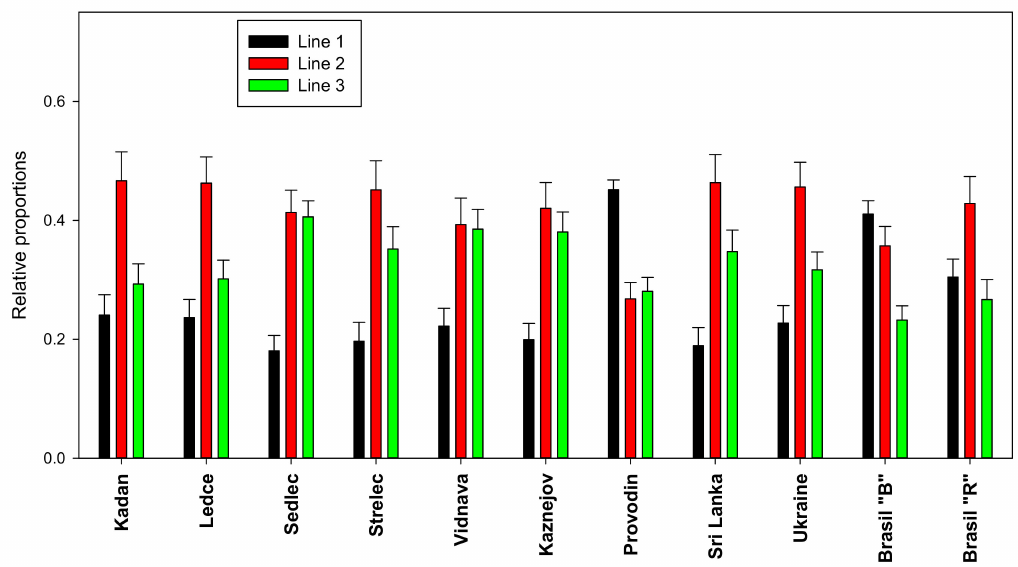
Figure 2. The proportion of the aluminum-ion coordination in the studied samples after thermal treatment (4 h at 750 ◦ C), obtained from 27 Al MAS NMR spectra (line 1—four- coordination, line 2—five- coordination, line